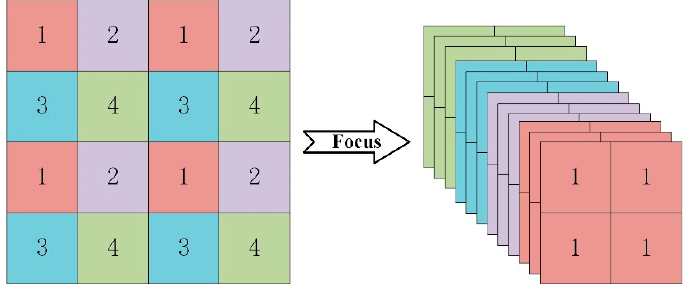
Figure 2. The effect of Mosaic data augmentation.